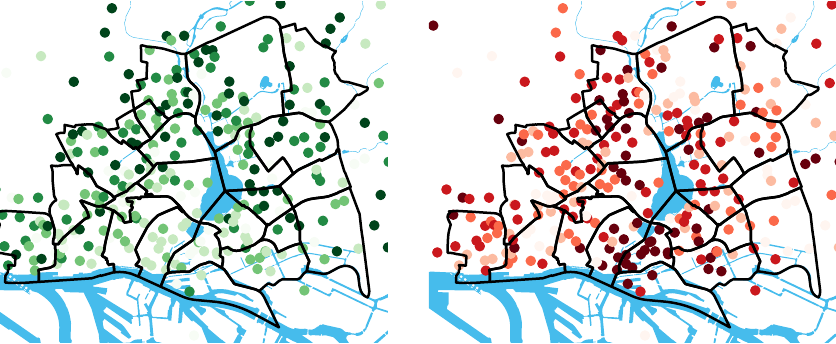
Figure 8. Overview of the spatial utilization of public chargers in Hamburg. Left : duration per transaction and charging station (quantiles); Right : number of transactions per charging station